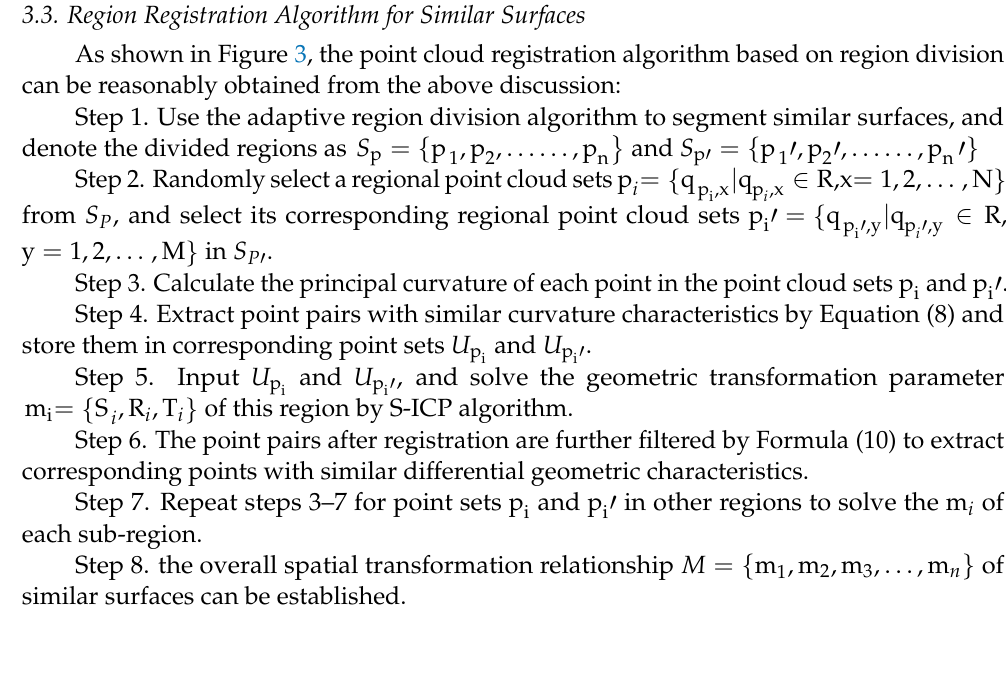
Figure 2. Local coordinate system and rotational deviation of corresponding points: ( a ) the local coordinate system of the corresponding point, ( b ) rotational deviation of the local coordinate system.